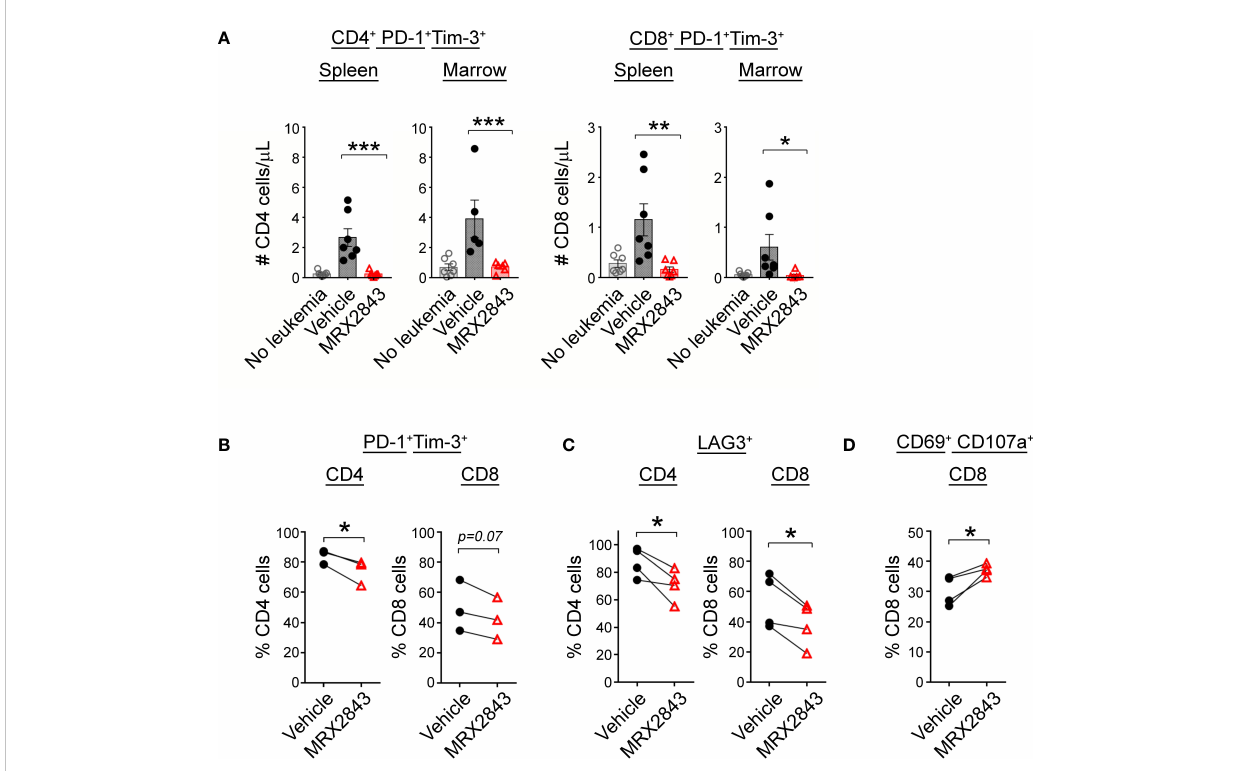
FIGURE 5 MerTK inhibition boosts T cells activation. (A) As described in Figure 1G, harvested spleen and marrow were analyzed by fl ow cytometry. Quanti fi ed CD4 + and CD8 + T cells co-expressing PD-1 and Tim-3 were analyzed using 1-way ANOVA. (B) Mixed human leukocyte co-cultures containing macrophages treated with MRX2843 or vehicle, AML cells and T cells were analyzed by fl ow cytometry. Percentage of cultured CD4 + and CD8 + T cells expressing (B) PD-1 and Tim-3, (C) LAG3, and (D) CD69 and CD107a. Analyzed using Student ’ s t-test. (*p<0.05, **p<0.01,